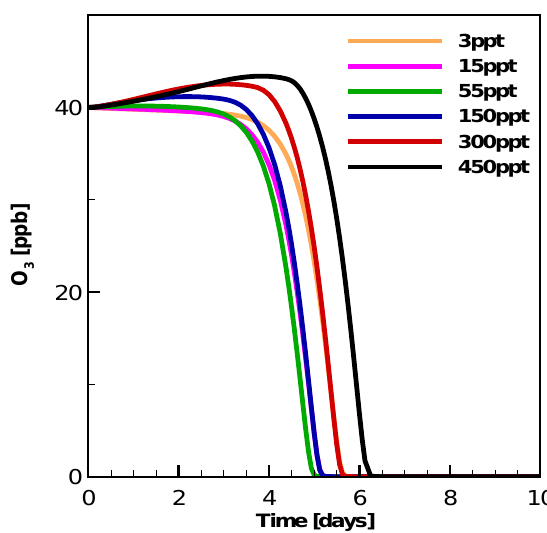
Figure 3. Depletion of ozone under different initial concentrations of NO